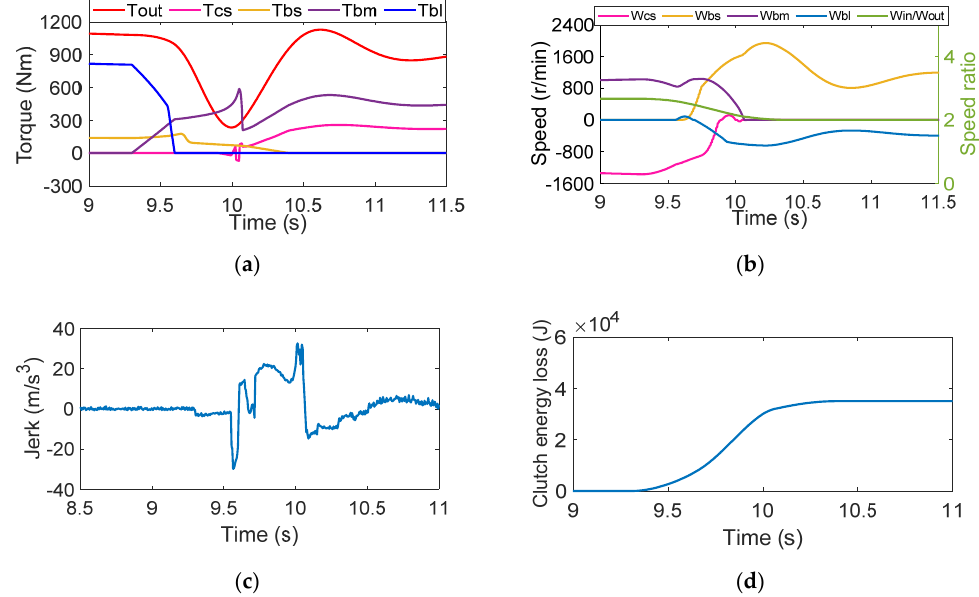
Figure 6. Simulation results of 2–3 power-on double-transition upshifts for Strategy 2. ( a ) Output shaft and clutch torque. ( b ) Clutch speed and speed ratio. ( c ) The jerk of shift process. ( d ) The clutch energy loss of shift process.